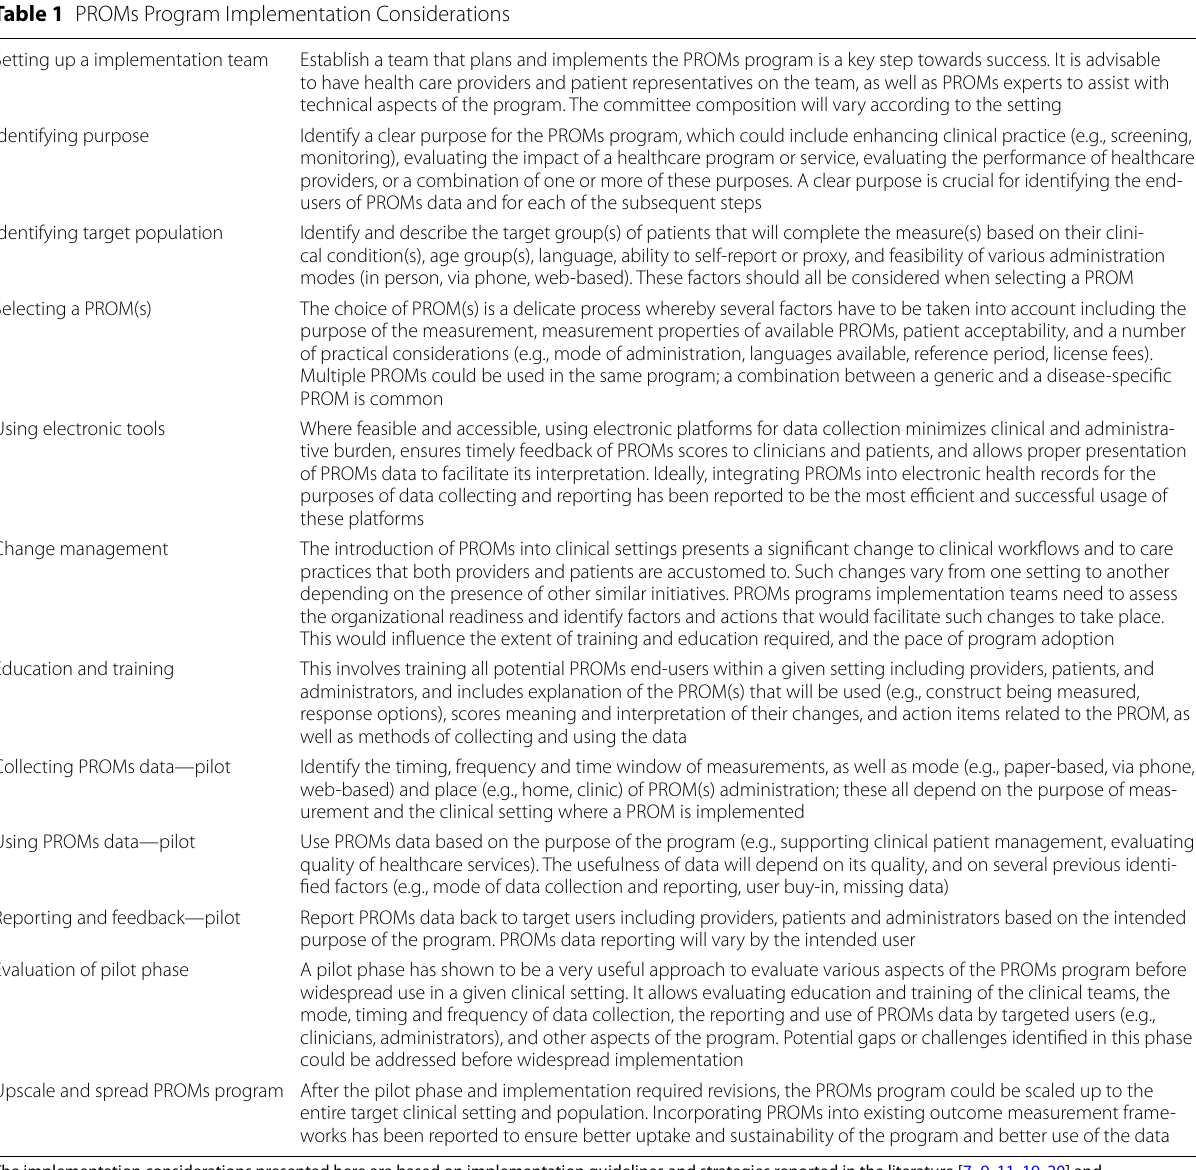
Table 1 PROMs Program Implementation Considerations Setting up a implementation